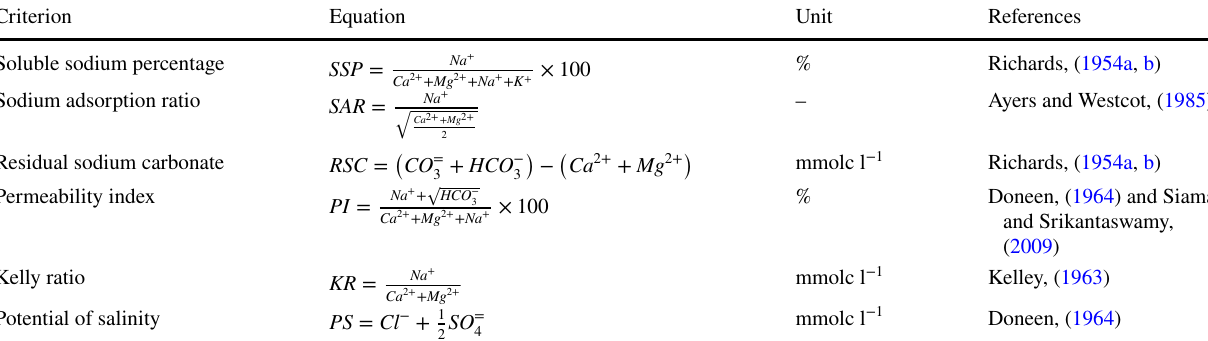
Table 1 The equation applied to calculate the water quality Criteria